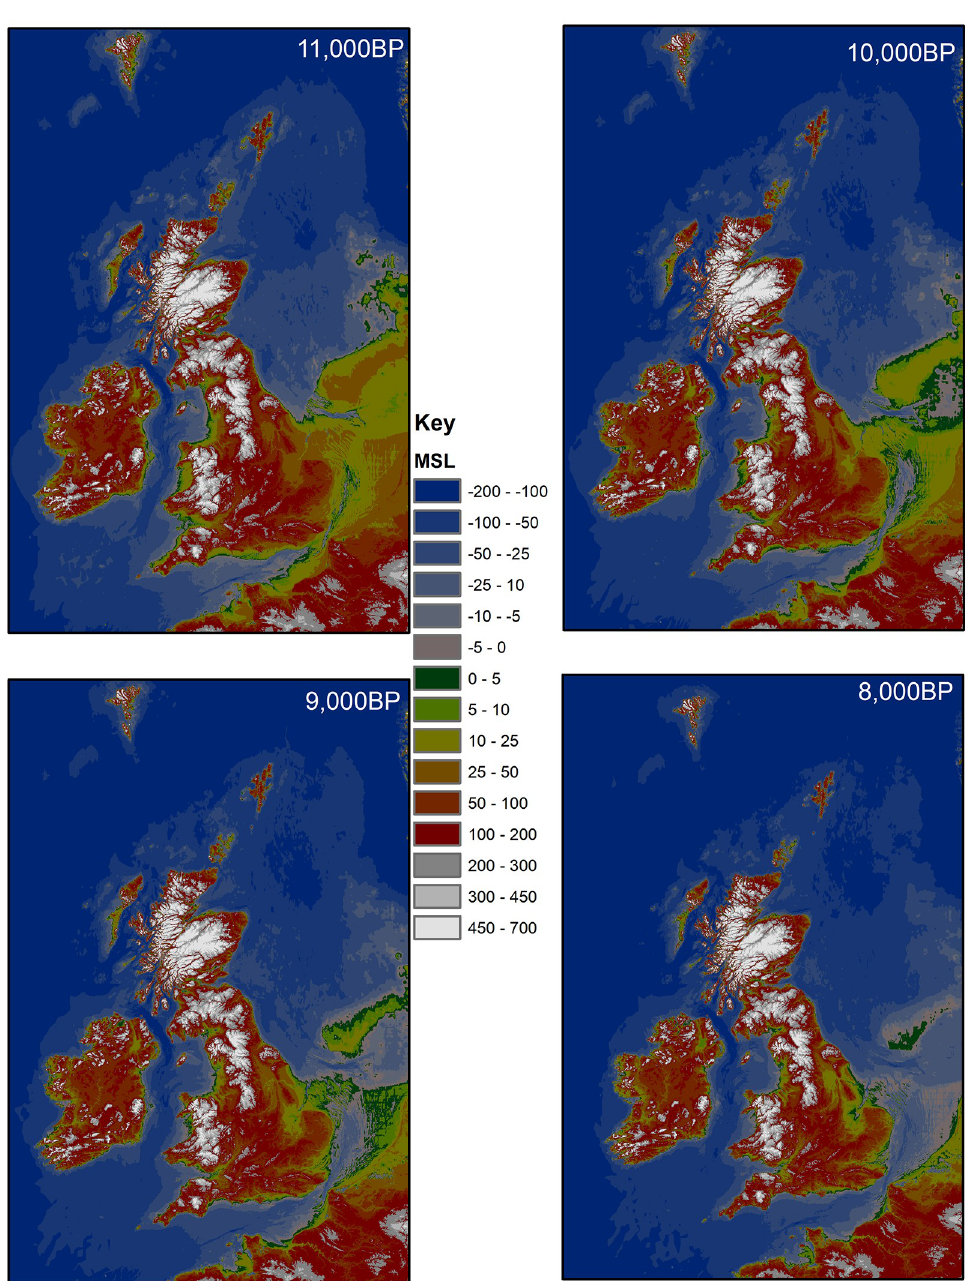
Fig 5. Palaeogeographic models of the North Sea drowning from 11,000 to 8000 cal BP. Map produced in part from Ordnance Survey Digimap, SeaZone solutions and GEBCO 08 (www.gebco.net) data. Produced by F. Sturt (University of